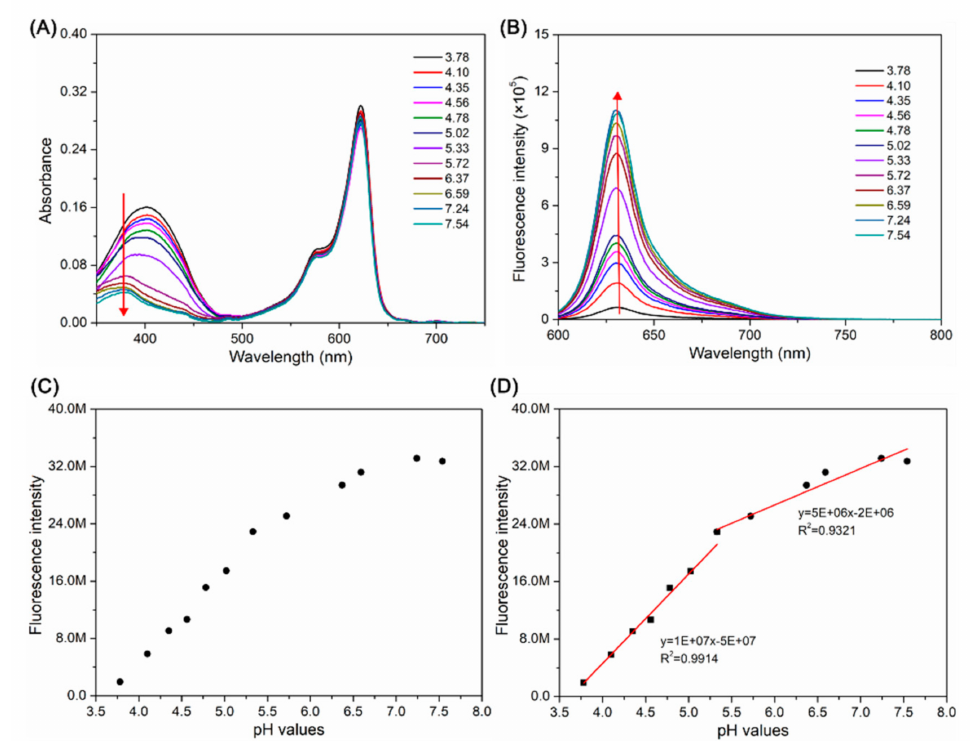
Figure 1. Absorption spectra ( A ) and fluorescent spectra ( B ) of BP (10 µ M) in the mixture of MeCN and B-R buffer solution ( v / v = 1:1) with different pH from 3.78 to 7.54, excitation: 590 nm. ( C ) Fluorescence intensity of BP (5 µ M) at 630 nm in B-R buffer solutions with 50% MeCN at different pH values. ( D ) The linear relationship between the fluorescence intensity of BP (10 µ M) at 630 nm and pH values (from 3.78 to